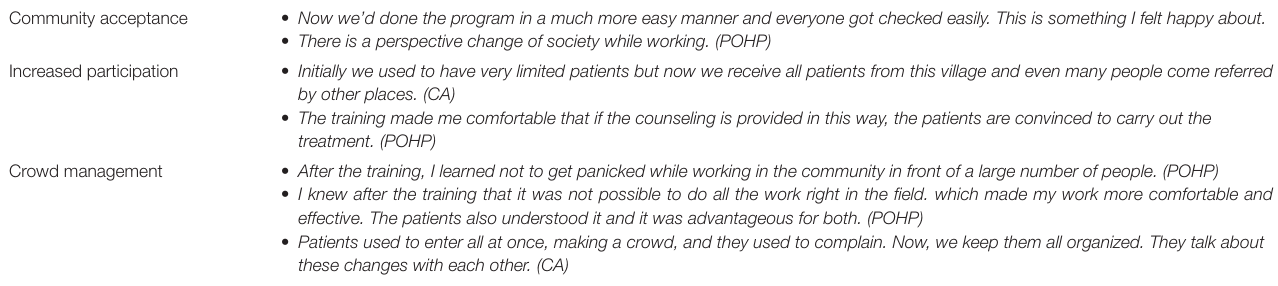
TABLE 4 | Community Impact. Community